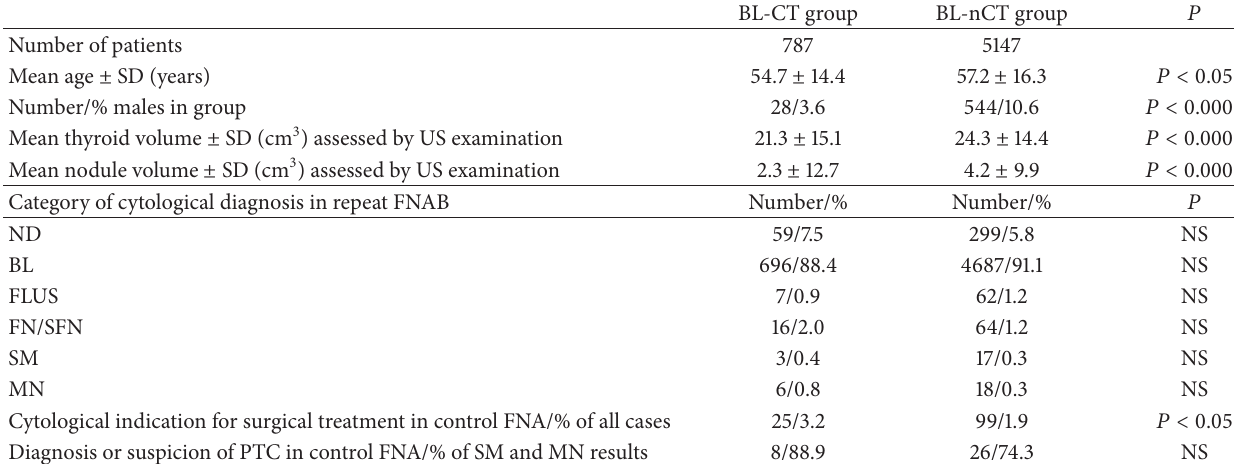
Table 1: Cytological diagnoses in repeat FNAs in patients of BL-CT and BL-nCT